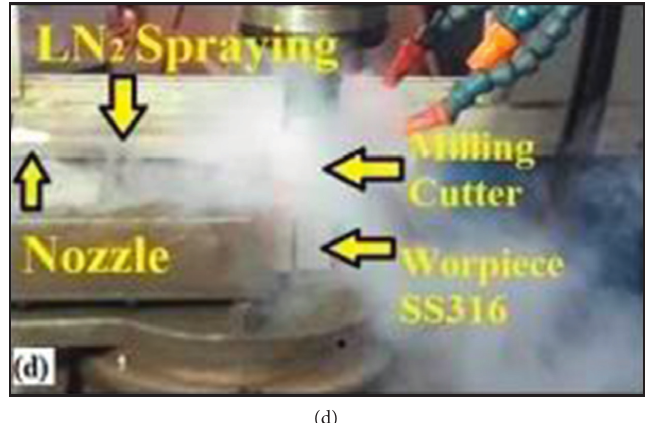
Figure 7: Cryogenic experimental setup with a start to end experimental instances. (a) Full cryogenic experimental setup used with different components, (b) experimentally used milling cutter and tool inserts with specifications, (c) nozzle positioned to the machining zone before the cryogenic machining, and (d) LN 2 sprayed to the machining zone during the cryogenic machining experiments.